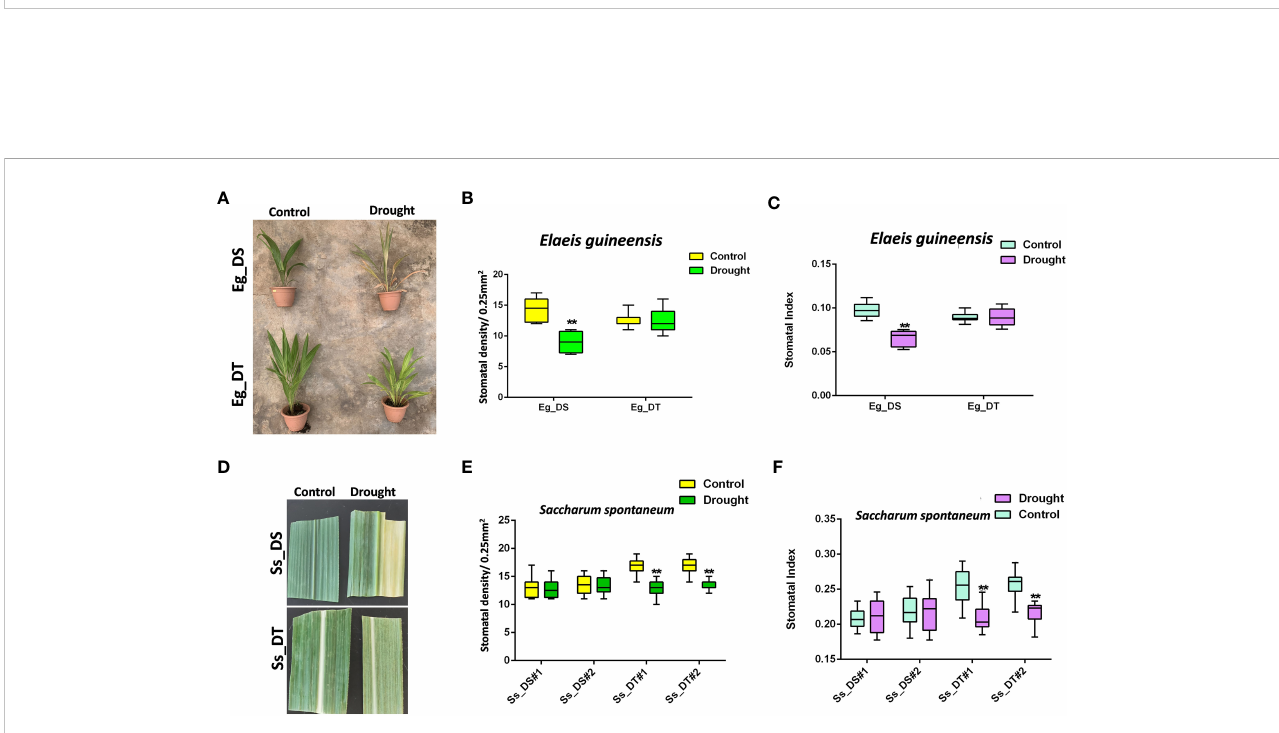
FIGURE 2 (A) The drought assay of drought-susceptible (Eg_DS) and drought-tolerant (Eg_DT) oil palms. Two-year-old oil palms were either continually watered or not watered for 14 days; n ≥ 4. (B) The stomatal density of samples from (A) . (C) The stomatal index of samples from (A) . (D) The drought assay of drought-susceptible (Ss_DS) and drought-tolerant (Ss_DT) sugarcanes. (E) The stomatal density of samples from (D) . (F) The stomatal index of samples from (D) . One-year-old sugarcanes were either continually watered or not watered for 21 days; n ≥ 2. The values are mean ± SEM; n ≥ 20. One-way ANOVA with post hoc Tukey HSD; **,